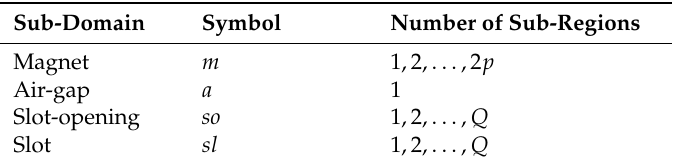
Table 1. The sub-domains and related